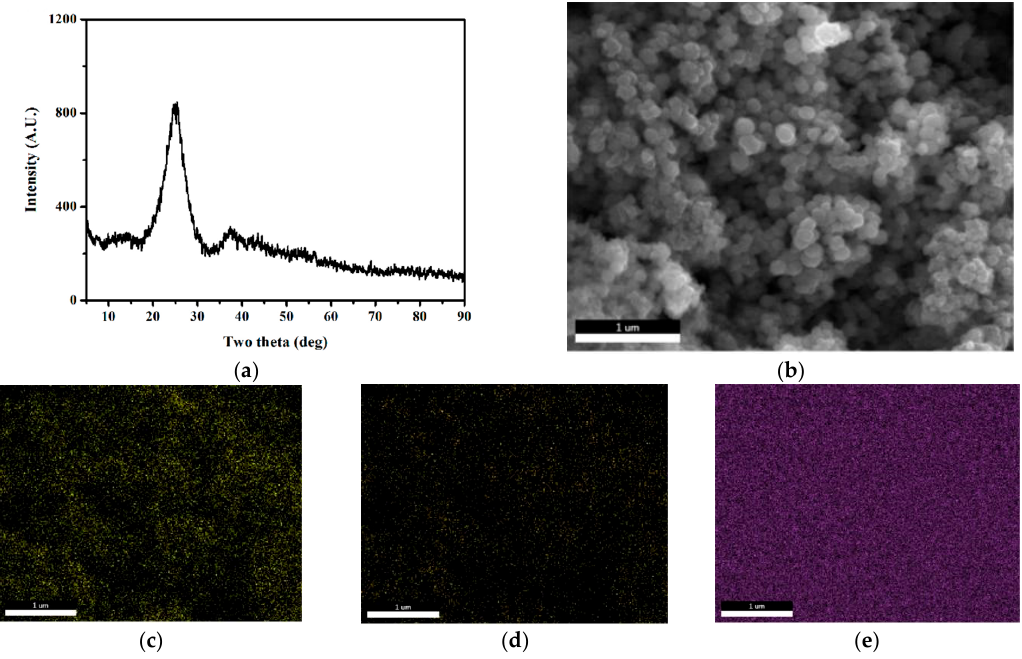
Figure 1. Morphology, structure characterization, and elemental analysis of the pristine sulfurized polyacrylonitrile (SPAN) nanocomposite: ( a ) XRD pattern and ( b ) FESEM image. EDAX elemental overlay of SPAN composite: ( c ) carbon, ( d ) nitrogen, and ( e ) sulfur in the sample shown in ( b ).